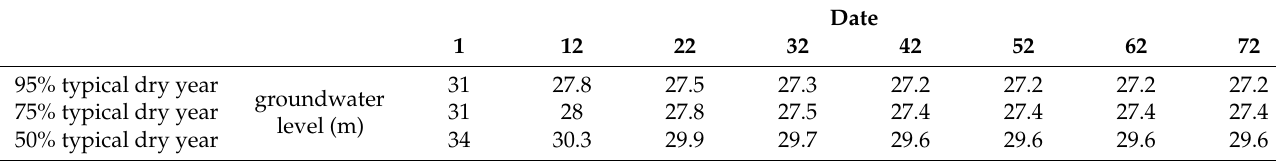
Table 7. Groundwater levels for different typical dry years.